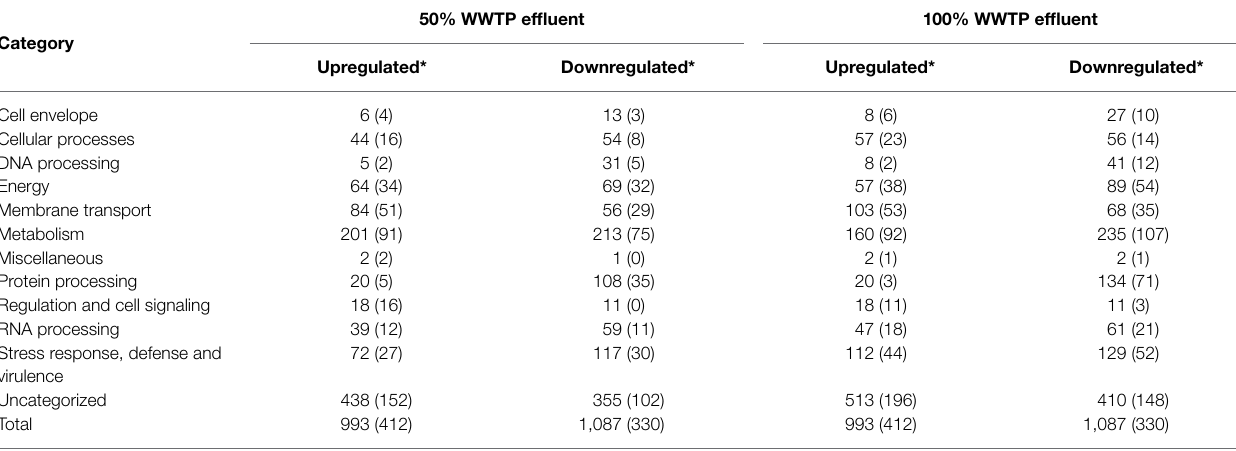
TABLE 2 | Vibrio vulnificus differentially expressed genes in wastewater by functional categories.